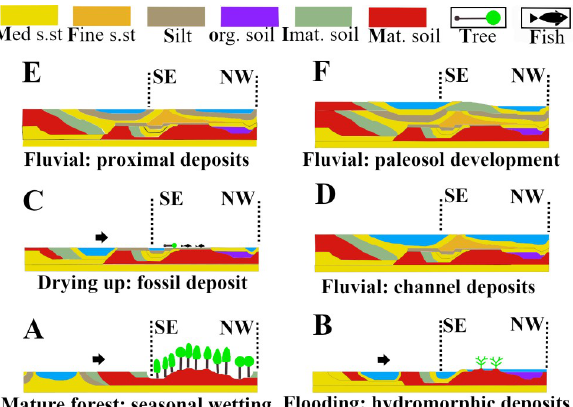
Fig 9. Interpretation of the depositional environments of the TCHD. The actual deposits of the TCHD are limited to the two vertical dashed lines shown in the figure. rooted area. The interpretation of the areas between the dashed line are extrapolations based on the thinning or thickening of the sediments at the TCHD: (A) A forest on an abandoned channel on a distant floodplain. (B) Crevasse splays changed the depositional environment from seasonal- pooling to permanent-pooling which resulted in the disappearance of the forest and preservation of the (C) A flood deposited washed-in fishes and young trees. (D) The crevasse splays and flood changed the local landscape by partially filling the local depression. Lateral migration of a local channel scoured part of the local depression and changed the depositional environment to an active channel. (E) Another lateral migration resulted in a channel bank deposit in the form of the heterolithic beds on the northwest side of the TCHD (F) Yet another episode of lateral migration followed by stabilization of the channel-bank at the northwest side of the TCHD that resulted in the development of the paleosols